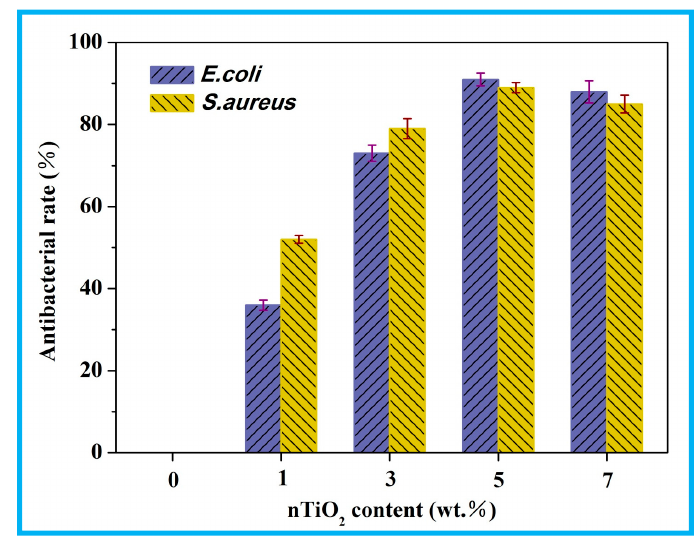
Figure 6. Antibacterial rate of the scaffolds with different nTiO 2 contents.